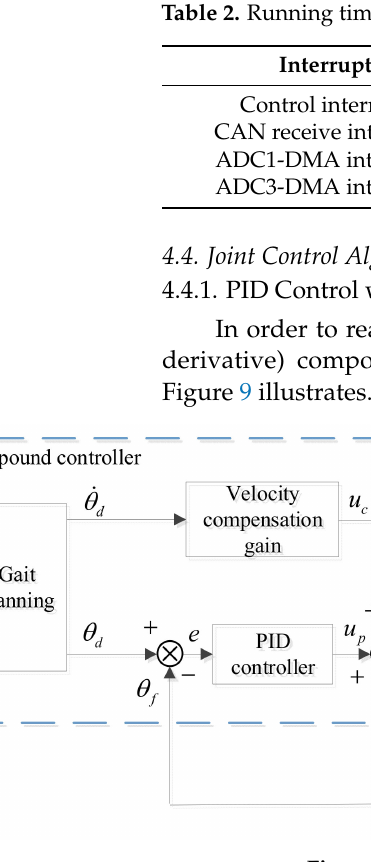
Figure 9. The block diagram of